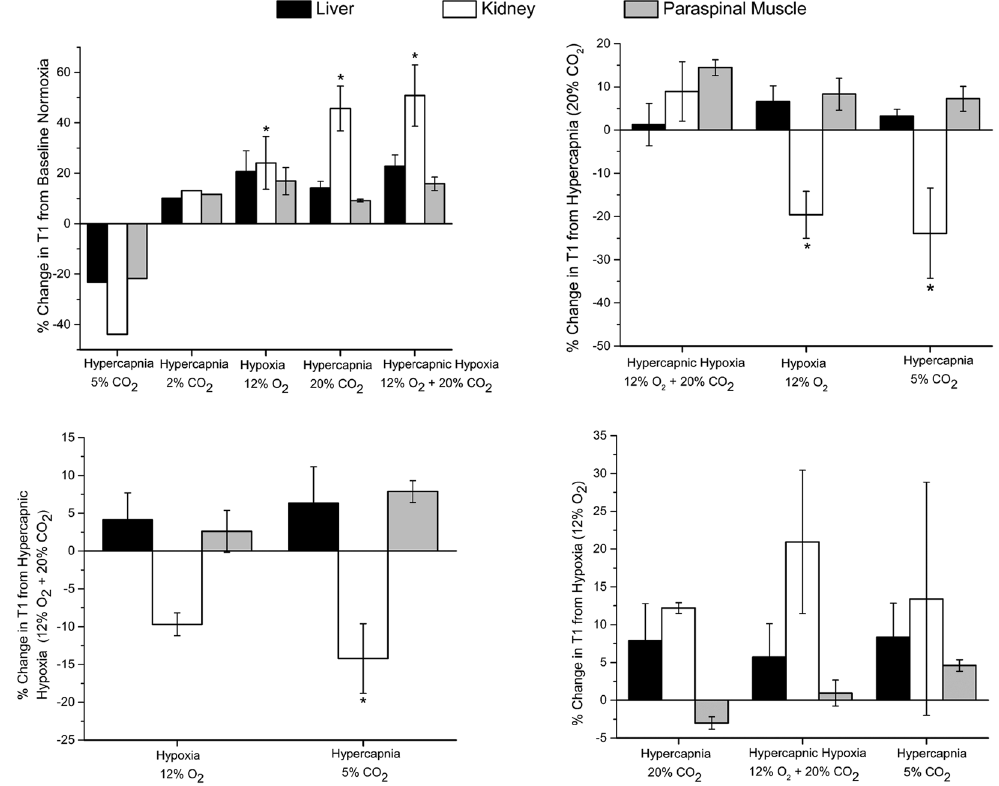
Figure 5. MRI response to gas challenges. Mean changes in T 1 relaxation times for different gas challenge regimes averaged across all animals ( N = 4 per group) and standard error are shown for the liver, kidney cortex, and paraspinal muscle. Exception is 2% CO 2 , which was studied in a single animal. Significant differences from baseline challenges are indicated ( * P <